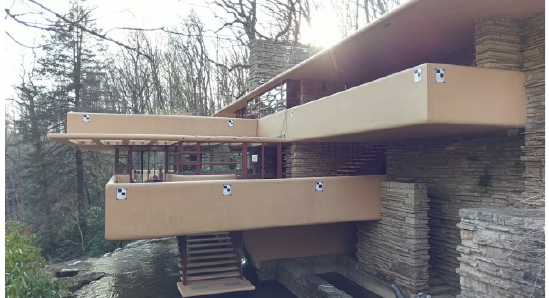
Figure 6. Scanning of the exterior of Fallingwater